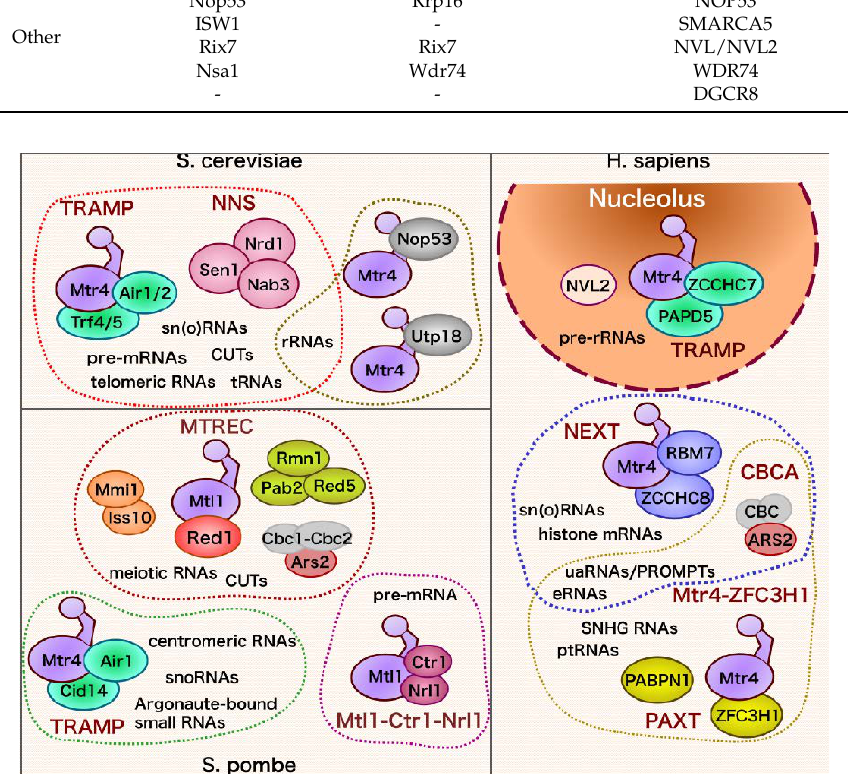
Figure 3. Overview of Mtr4-containing exosome adaptor complexes in yeasts and humans. The RNA helicase Mtr4 participates in multiple distinct exosome adaptor complexes to complete degradation and/or processing of specific RNA substrates. Mtr4-containing complexes identified in Saccharomyces cerevisiae ( upper-left ), Schizosaccharomyces pombe ( lower left ) and Homo sapiens ( right ) are shown.